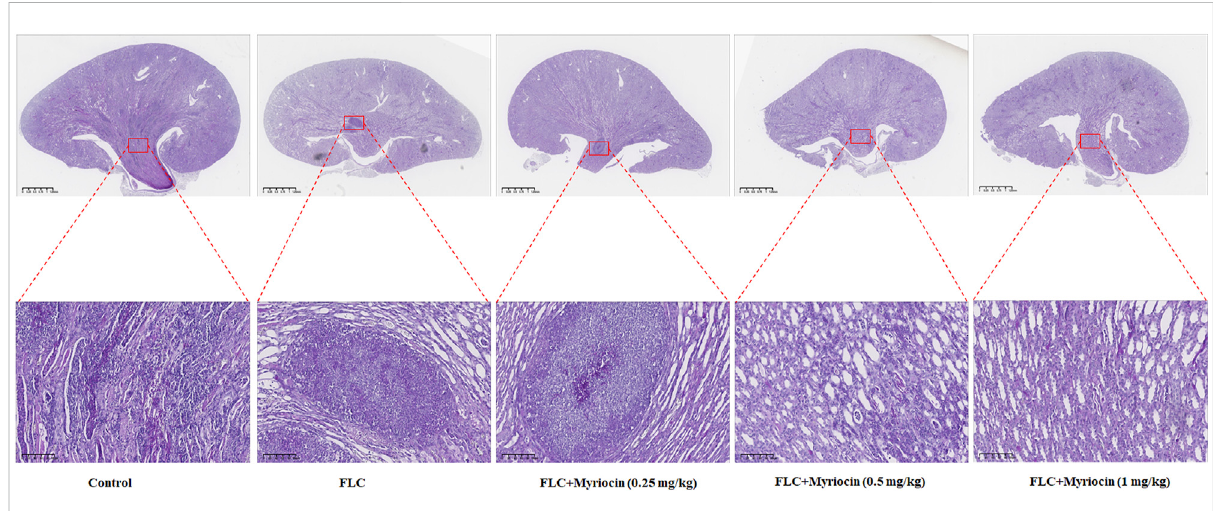
Kidneys from mice ( n = 6 per group) were fi xed and stained with periodic acid Schiff stain for histopathology. Scale bar, 100 μ m/1.25 mm. The experiment was performed in biological